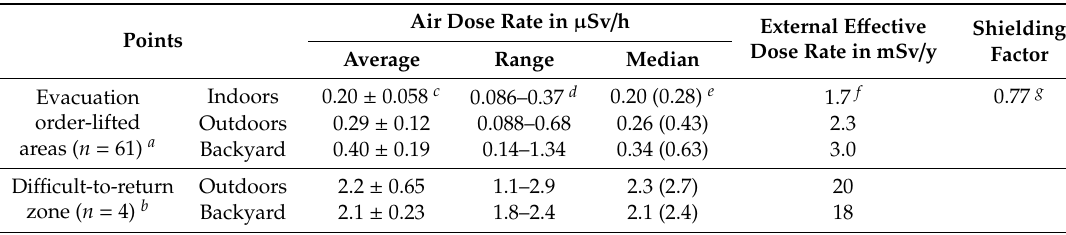
Table 1. Air dose rates around residences and assembly halls in Tomioka town, Fukushima Prefecture,